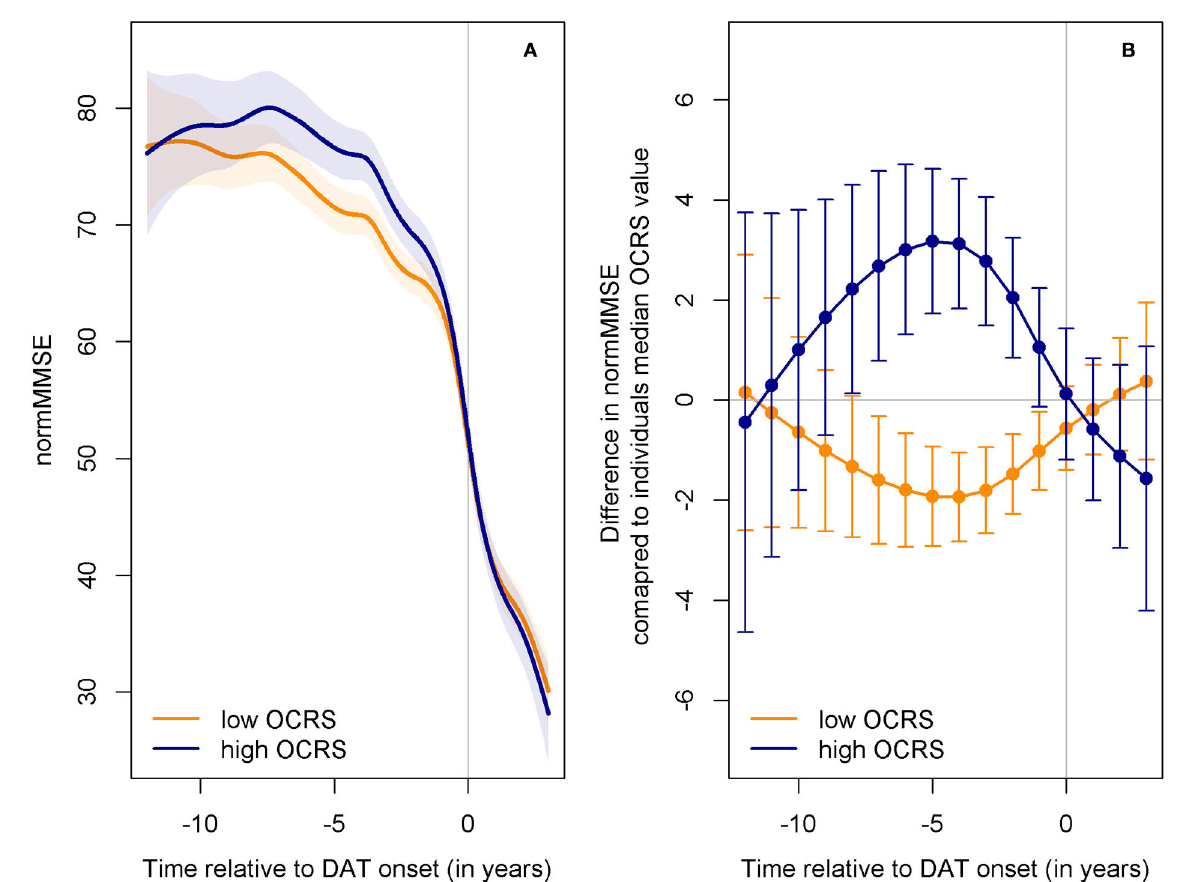
FIGURE5 Predicted trajectories of cognitive decline in AgeCoDe before DAT onset depending on OCRS. (A) Predicted trajectories in the normalized MMSE (normMMSE) (Philipps et al., 2014) relative to the onset of DAT for individuals with either low (25th percentile) or high (75th percentile) OCRS levels. The normalized MMSE has a range of 0 to 100. Shaded areas indicate 95% confidence intervals. Individuals with high OCRS (blue line) show stable cognitive function for a longer period than individuals with low OCRS (orange line). However, they decline stronger after the onset of deterioration. Both groups show equal levels of performance at dementia onset. Afterward, high OCRS is associated with slightly lower levels of cognitive function. (B) Predicted differences of individuals with high (75th percentile) or low OCRS (25th percentile) compared to individuals with median OCRS values at different time points relative to DAT onset. Bars indicate 95% confidence intervals. Differences are computed from the sum of OCRS smooth terms [ti(OCRS) in the mgcv package] and OCRS and time tensor product interaction terms [ti(time,OCRS) in the mgcv package]. While high OCRS (blue line) shows an increasingly protective association with cognitive function until ∼ 5 years before dementia onset, this association diminishes and predicted cognition is even lower than in individuals with low OCRS (orange line) after DAT onset.